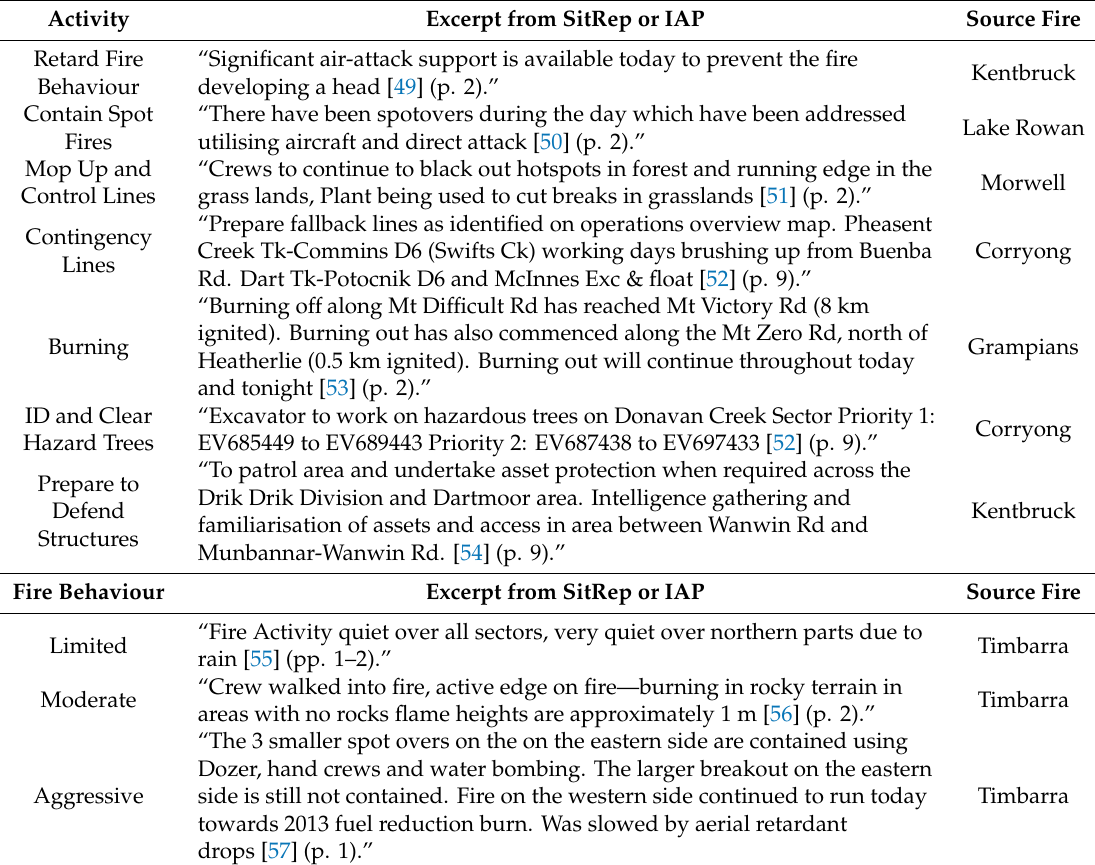
Table 4. Illustrative excerpts of the range of o ff ensive suppression tasks and fire behaviour. Activity Excerpt from SitRep or IAP Source Fire Retard Fire Behaviour